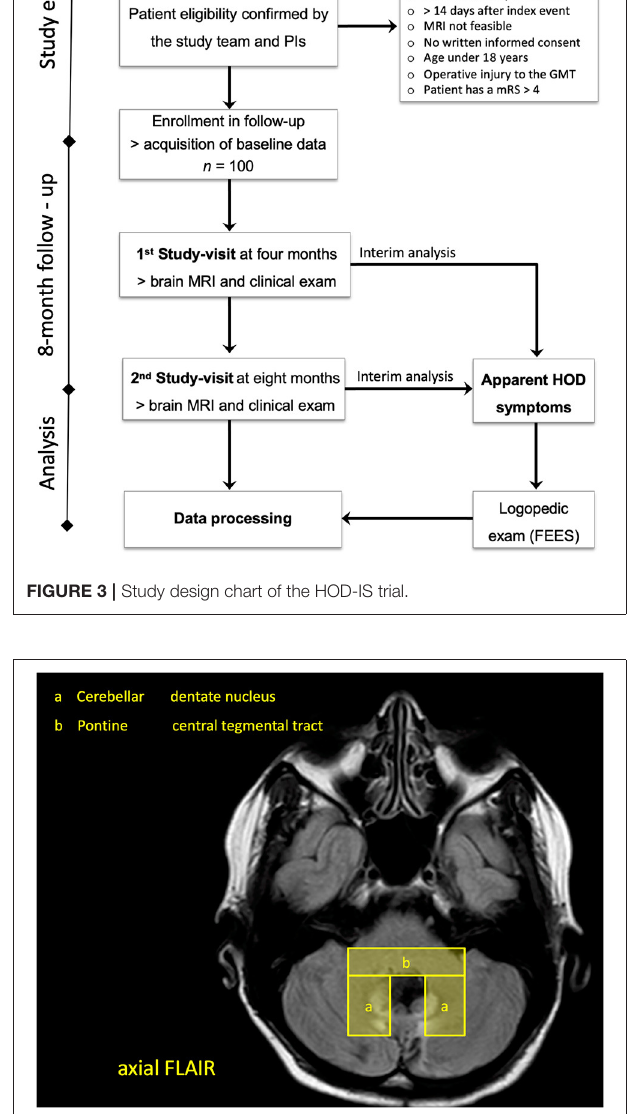
radiological findings, (b) the acquisition of MRI double-echo PD-/T2-weighted images to analyze the best detectability of radiological HOD in comparison to conventional T2-weighted sequences, and (c) the assessment of PT associated dysphagia by a follow-up examination by speech therapists with Fiberoptic